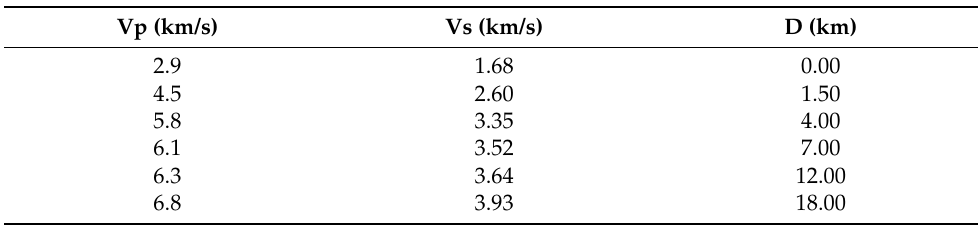
Table 1. Specifications of the seismic velocity model used; Vp and Vs are velocities of P and S waves, respectively; D is layer